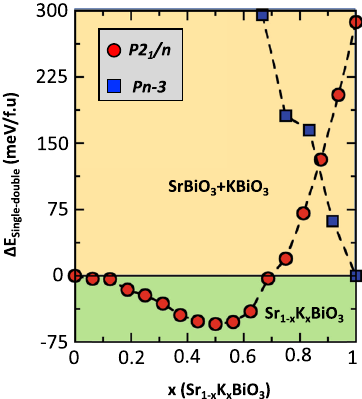
Fig. 4 Miscibility of K within the SrBiO 3 structure. Energy difference (in meV/f.u) between the P2 1 /n (red- fi lled circles) and Pn-3 (blue- fi lled squares) symmetry with respect to a biphasic solid solution as a function of the doping